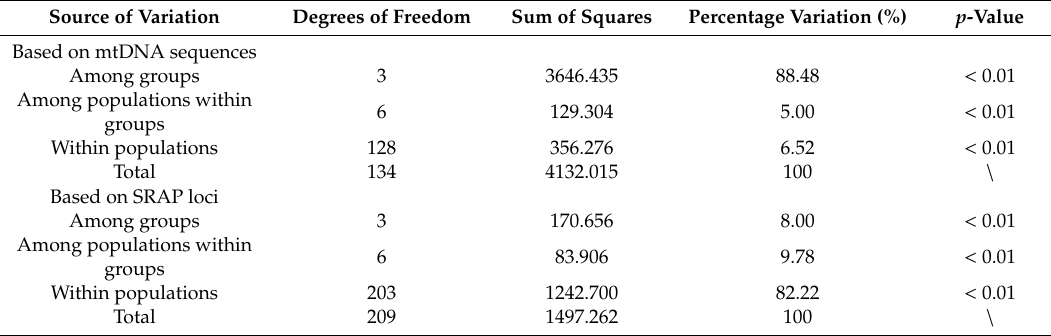
Table 4. Analysis of molecular variance (AMOVA) of 7 populations in the genus Megalobrama based on combined mtDNA sequences (3116 bp) and 15 SRAP loci.